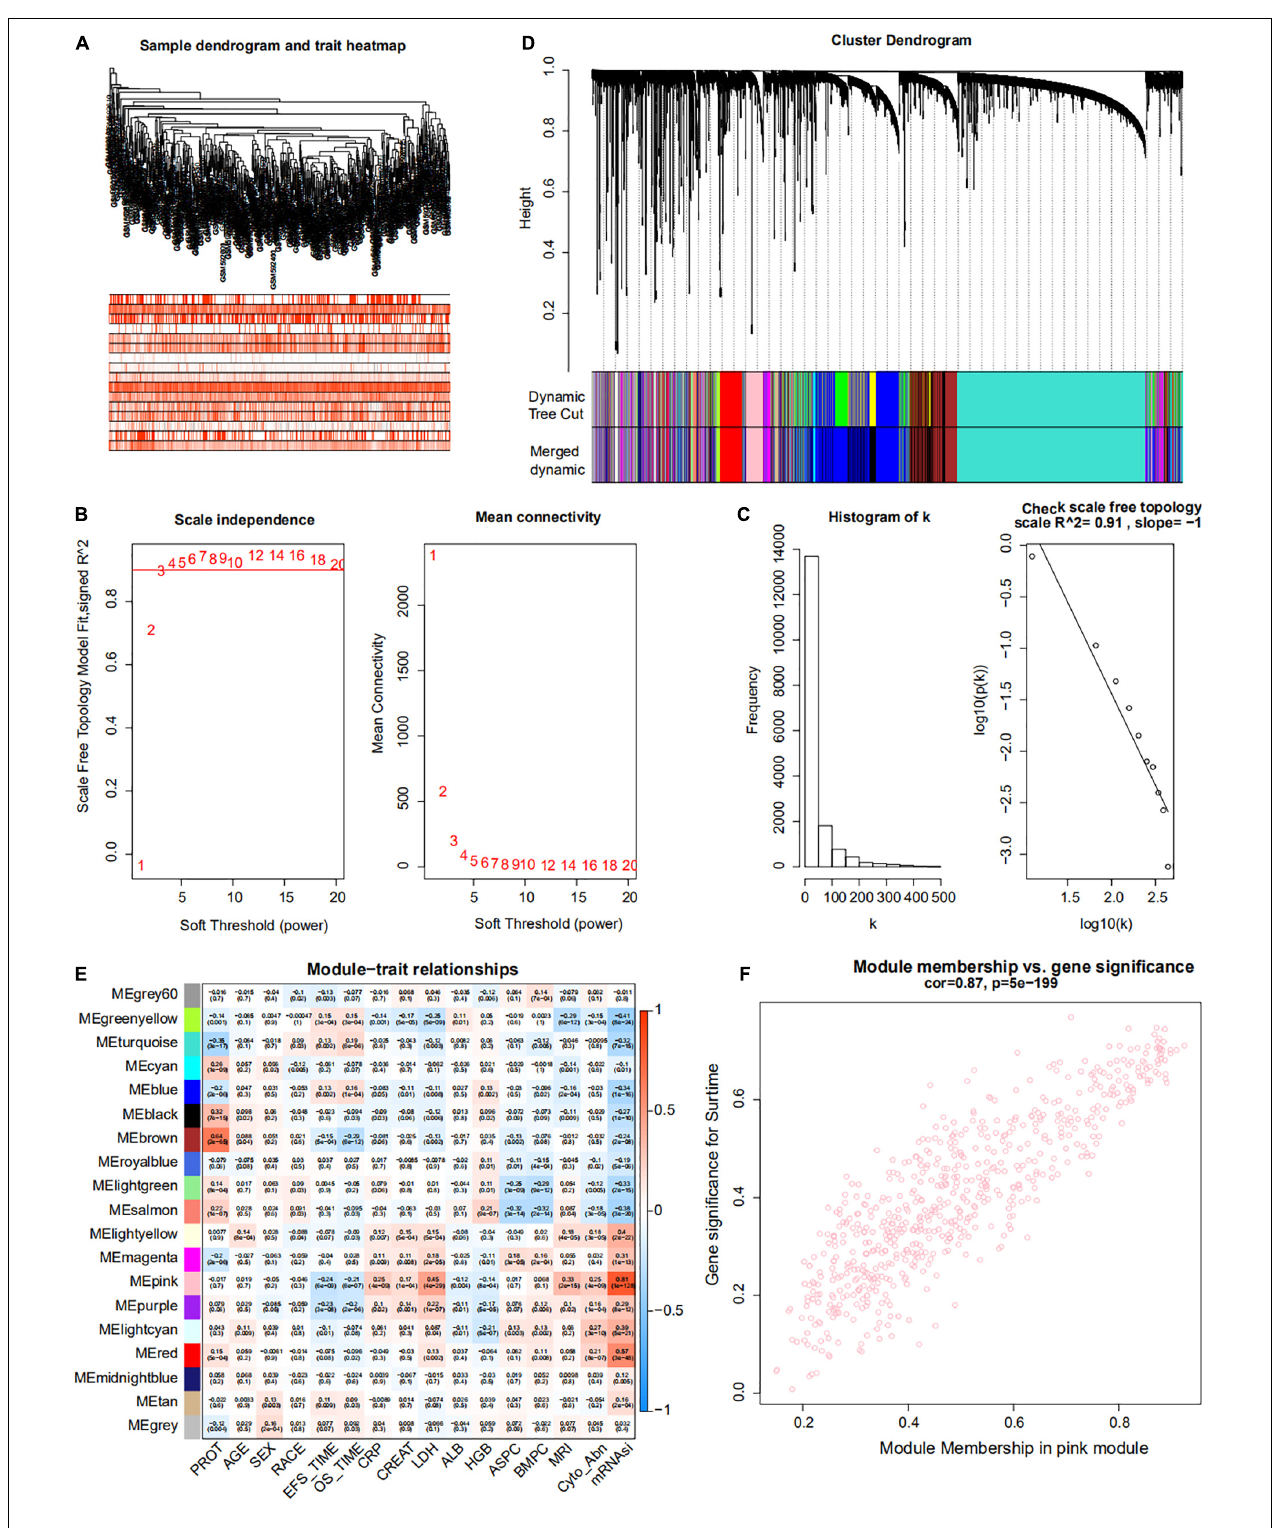
FIGURE 5 | Weighted gene co-expression network of MM of the GSE24080 cohort. (A) Sample dendrogram and trait heatmap. The colors represent the proportion of clinical traits. (B) Left panel: the scale-free topology fit index for soft-thresholding powers. Right panel: mean connectivity for soft-thresholding powers. (C) Scale-free R 2 ( R 2 = 0.91). (D) Clustering dendrogram of genes in patients with MM. (E) Pertinence between clinical traits and gene modules. (F) Scatter plots of gene significance (GS) for mRNAsi corresponding to module membership in the pink module, with their correlation coefficients and P